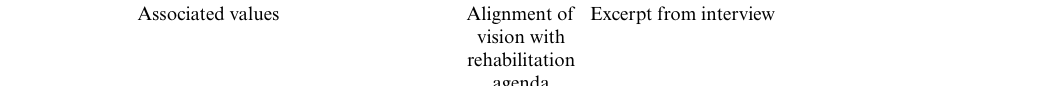
Excerpt from vision with rehabilitation agenda